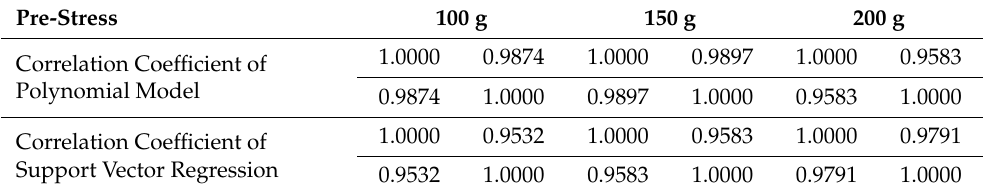
Table 11. Correlation coefficient at different